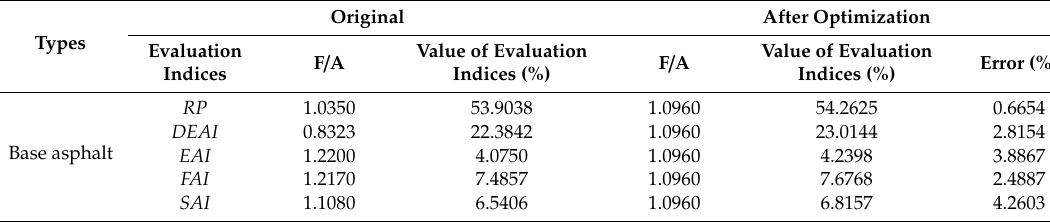
Table 9. Results of unified optimal F / A of base asphalt